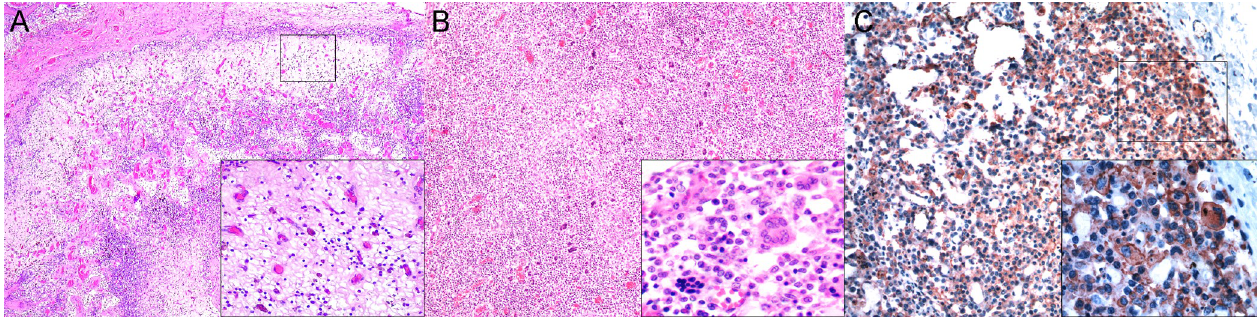
Fig 3. Cetacean morbillivirus (CeMV)-associated lesions in lymph nodes and spleen of striped dolphins ( Stenella coeruleoalba ), bottlenose dolphins ( Tursiops truncatus ), and Guiana dolphins ( Sotalia guianensis ). (A) Pulmonary lymph node (case 27). Severe cortical and paracortical lymphoid depletion. 40x. H&E. Inset: Higher magnification of the squared area in 3A depicting severe cortical lymphoid depletion. 200x. H&E. (B) Mediastinal lymph node (case 13). Paracortical expansion and numerous multinucleate giant cells/syncytia (MGCS). 40x. H&E. (C) Mediastinal lymph node (case 2). There is diffuse morbilliviral antigen in depleted cortex, paracortex, and sinusoidal leukocytes. 20x. IHC for CeMV. Inset: Diffuse morbilliviral labeling, including MGCS, at squared area in 3E. 400x. IHC for